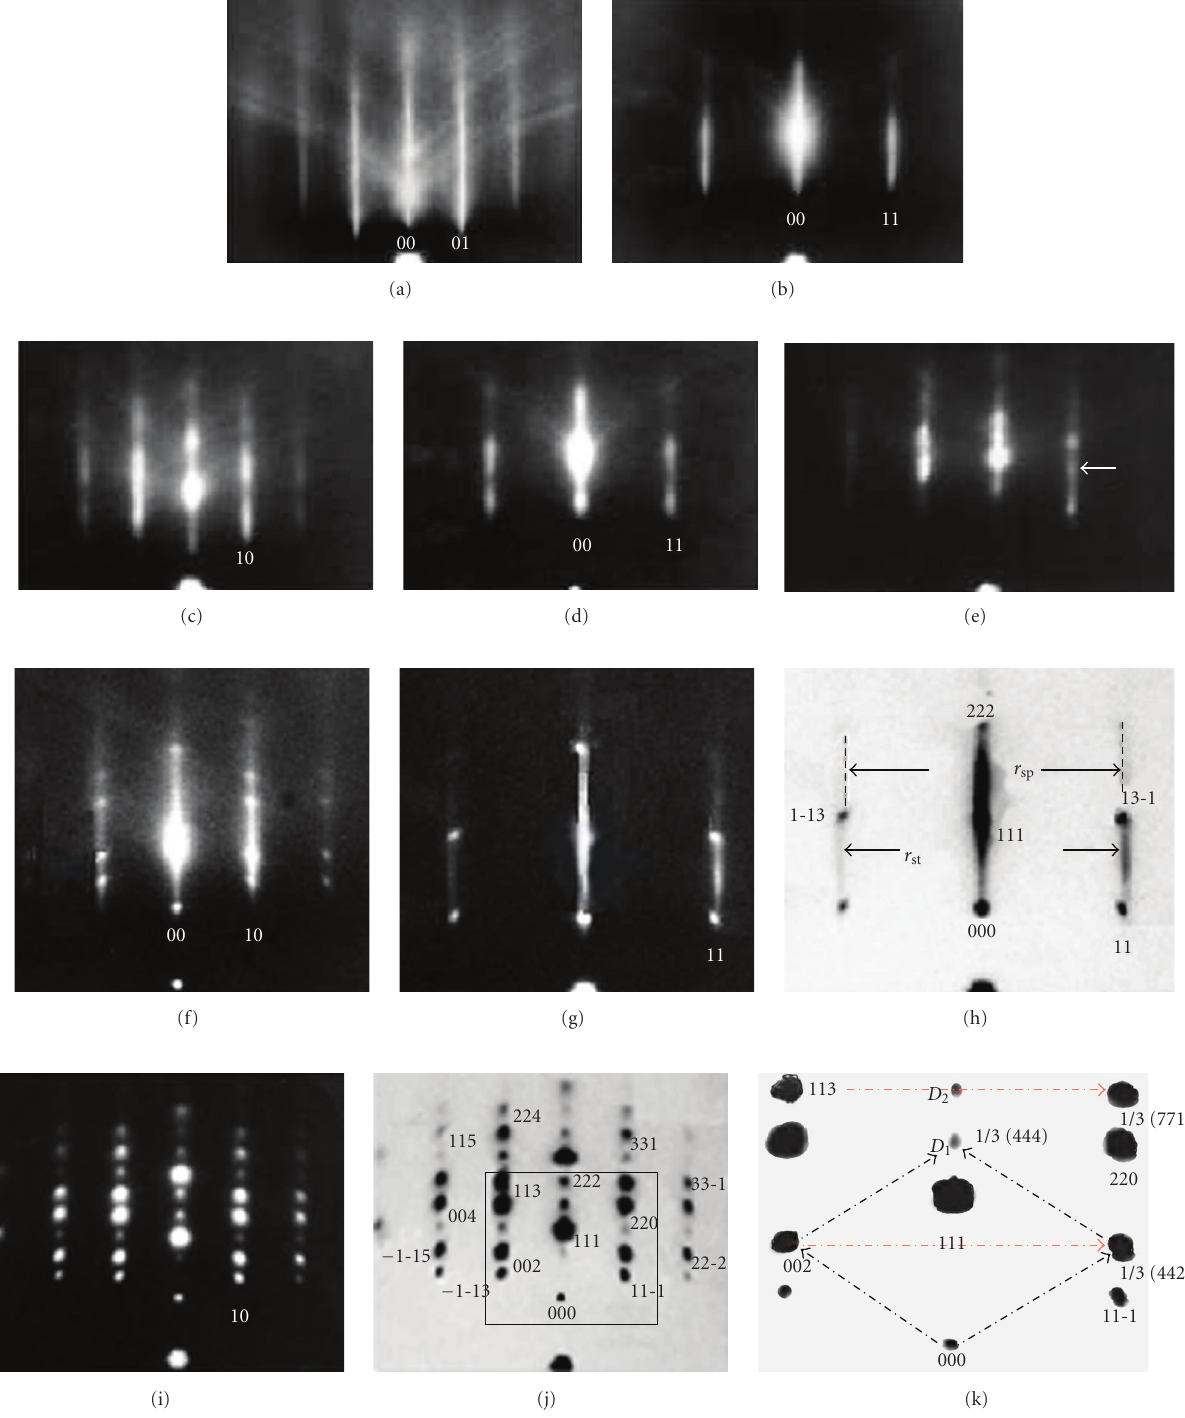
Figure 1: (1 × 1) RHEED patterns ([11-20] (a) and [0110] (b)) for Ru(0001) after argon ion sputtering and annealing at 1300 K under UHV conditions, showing 2D reflection streaks of the ( ± 10) and ( ± 11) beams; the RHEED patterns ([11-20] (c) and [0110] (d)) for Ru(0001) electrode covered by submonolayer Pt, showing intensity modulation along the substrate reflection rods; the RHEED pattern ([11-20]) for the Ru(0001) electrode covered by Pt deposit after second spontaneous deposition, showing additional reflection depicted by the arrow along the Ru substrate reflections ( ± 10); the RHEED patterns ([11-20] (f) and [0110] (g)) for the Ru(0001) electrode covered by Pt ( > 1ML) by spontaneous deposition ( > 3 min), showing 3D spots due to the Pt clusters; the indexed reciprocal lattice (h) of Figure 1(g); the RHEED pattern [11-20] (i) and its indexed reciprocal lattice (j) for the Ru(0001) electrode covered by Pt ( > 1ML) by electrodeposition; (k) the indexed reciprocal lattices of the matrix and the twin for the marked part of Figure